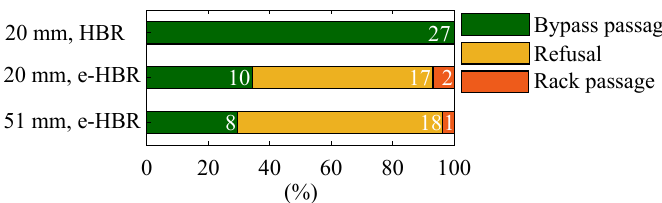
Figure 6. Results of the live fish tests with spirlin ( Alburnoides bipunctatus ) with U o = 0.5 m/s and U by , in = 0.6 m/s, without and with an electric field for different bar spacings s b . The green bar represents the fish guidance efficiency FGE, and the sum of the green and yellow bars represents the fish protection efficiency